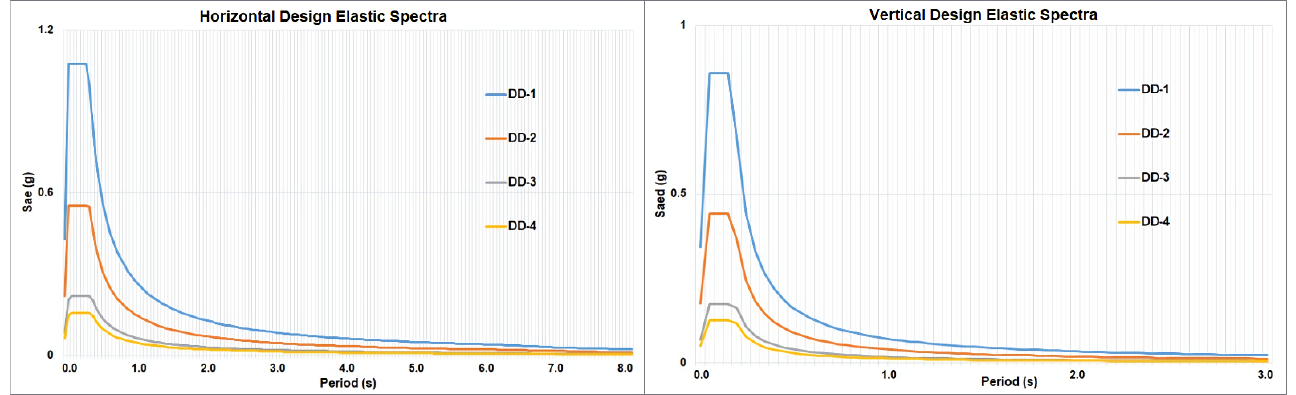
Figure 16. Comparison of horizontal and vertical elastic design spectra obtained for different probabilities of exceedance.